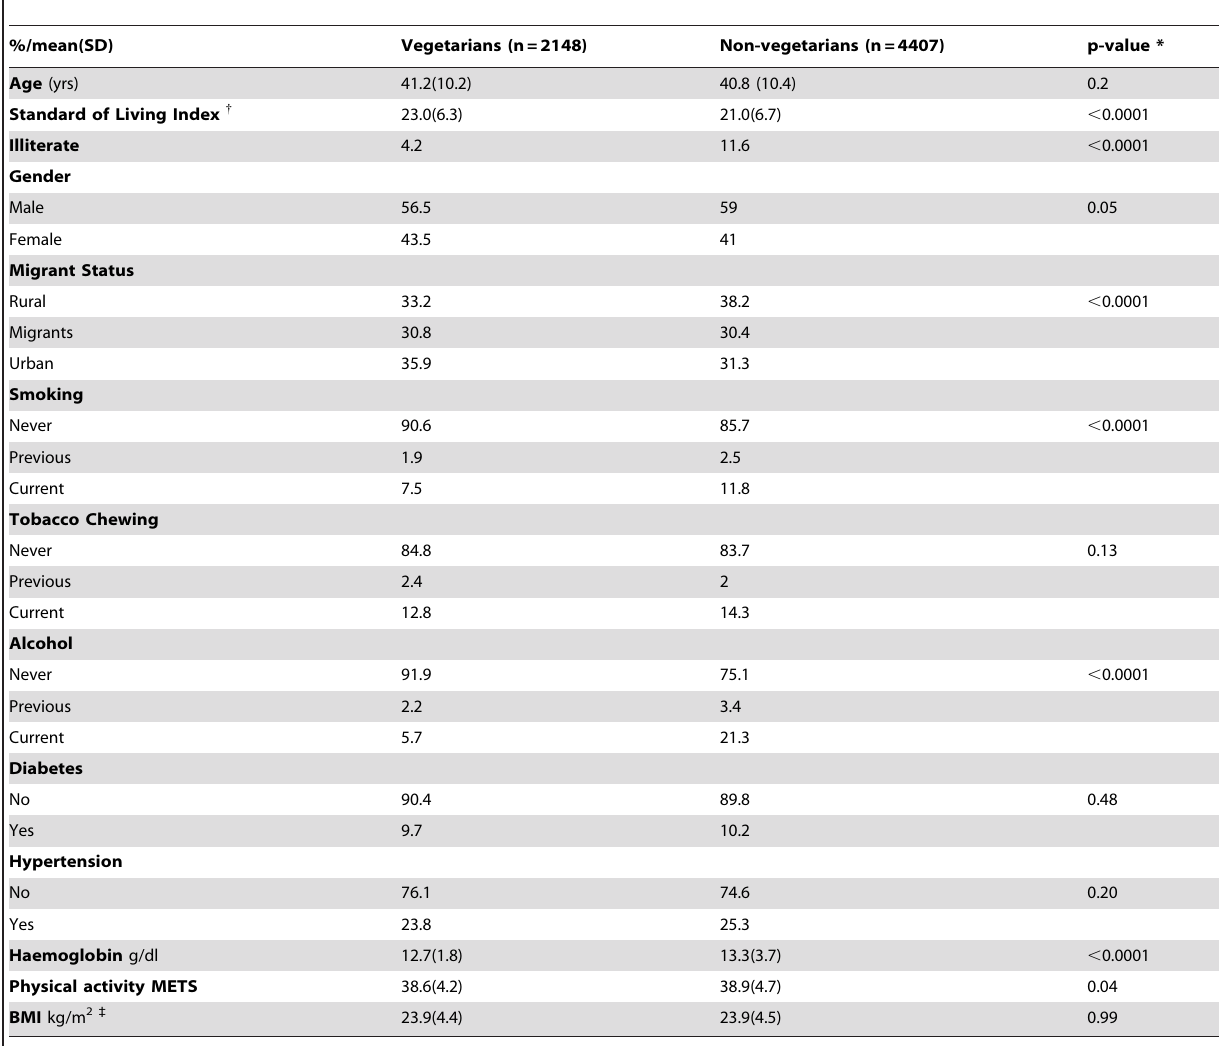
Table 1. Socio-demographic and lifestyle characteristics of Indian Migration Study